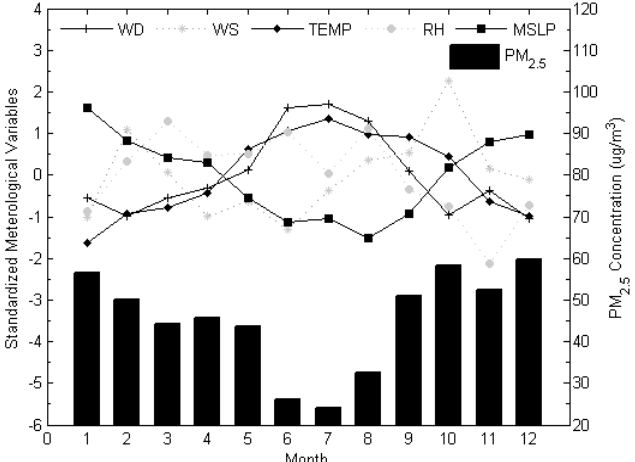
concentrations and meteorological 2.5